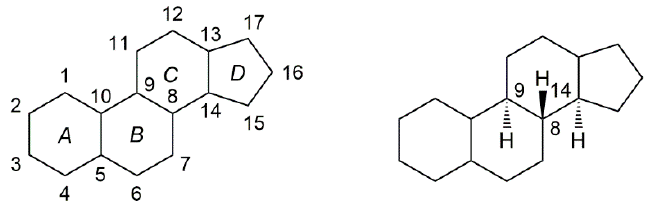
Figure 1. General structure of steroidal scaffold (left). Unless implied or stated to the contrary, the configuration of hydrogen atoms at the bridgehead positions 8, 9 and 14 are oriented as shown in the right formula (i.e., 8 β , 9 α , 14 α ).